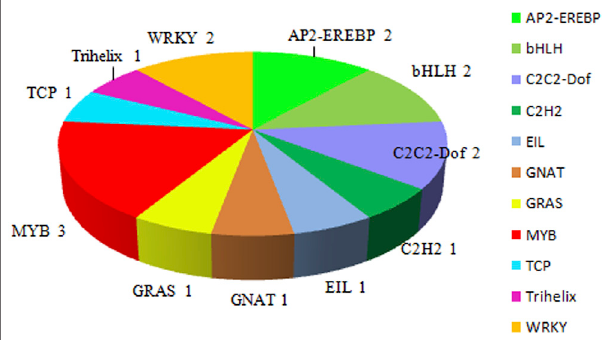
FIGURE 4 | Transcription factor groups identi fi ed among the 424 differentially expressed